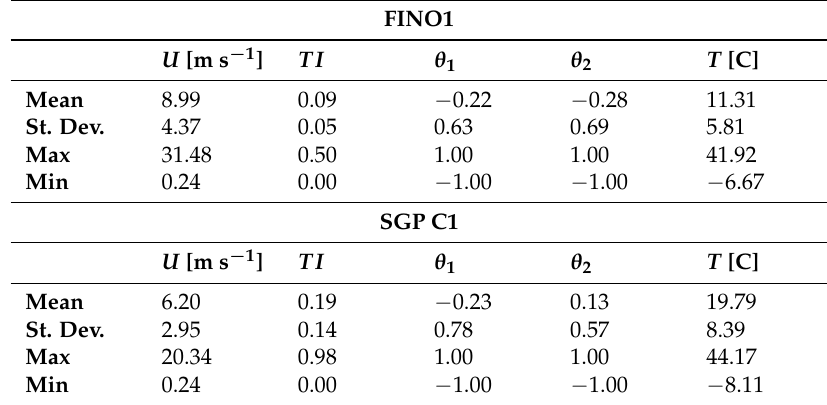
Table 1. Input variable statistics for the FINO1 and SGP C1 training datasets. θ 1 and θ 2 represent the North-South and East-West components of wind direction,